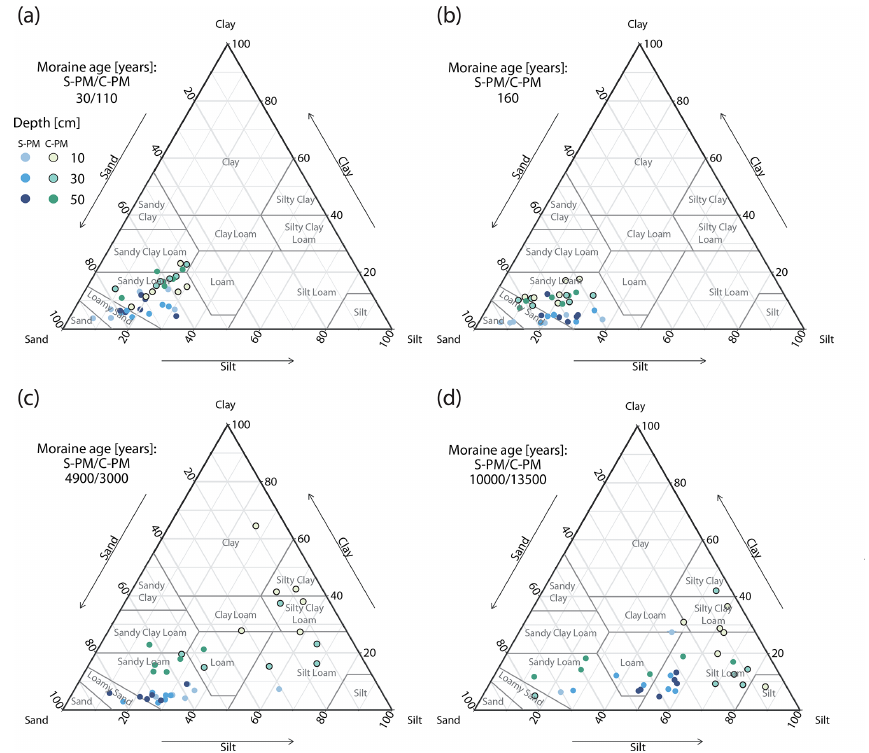
Figure 4. Ternary diagram for soil type classification using the USDA Textural Soil Classification. Each plot shows a single age class and compares the grain size distributions of both parent materials and all three depths.